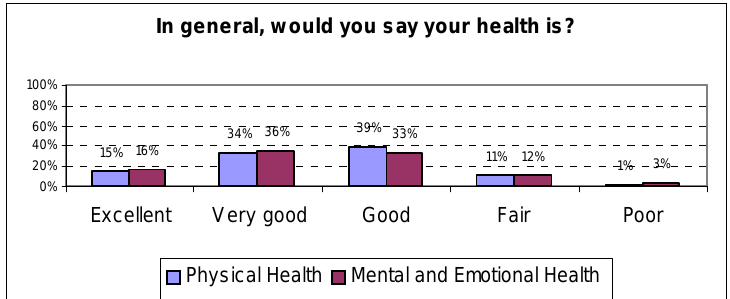
Physical Health & Mental and Emotional Health (2